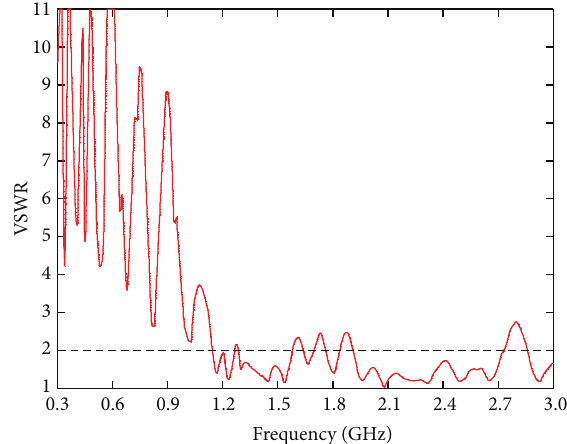
Figure 6: Measured VSWR of the designed antenna.